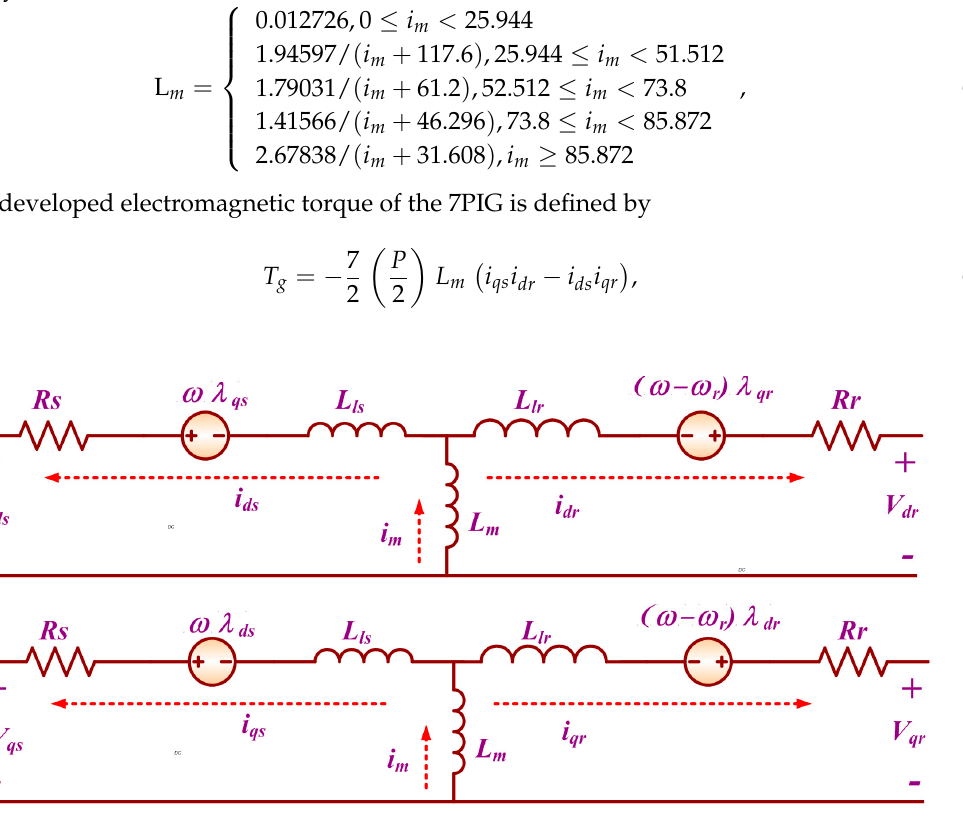
Figure 2. d-q- axis Equivalent Circuit of Seven-Phase Induction Generator (7 P IG). Figure 2. d-q -axis Equivalent Circuit of Seven-Phase Induction Generator (7PIG). A negative (-ve) sign indicates generation